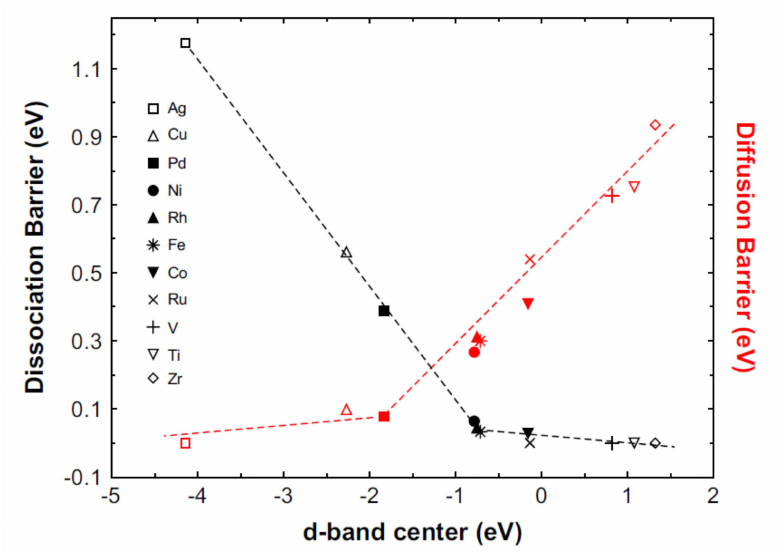
Figure 7. Activation energy barrier for hydrogen dissociation (black) and diffusion (red) of hydrogen on pure Mg and metal-doped Mg surfaces as a function of the d-band center positions [53]. (Reprinted with permission from Elsevier).